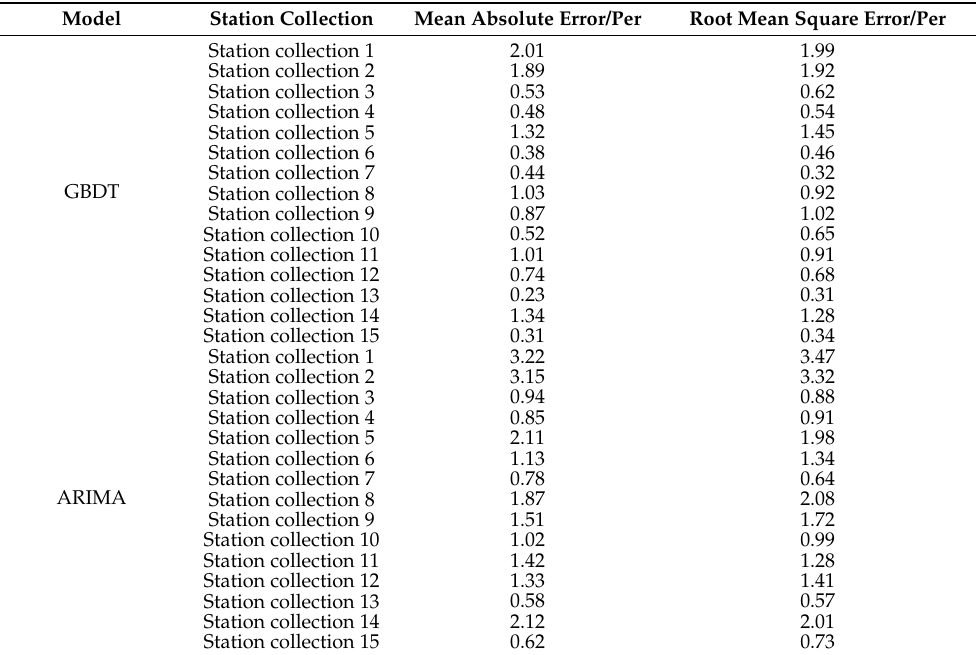
Table 7. Prediction error analysis.